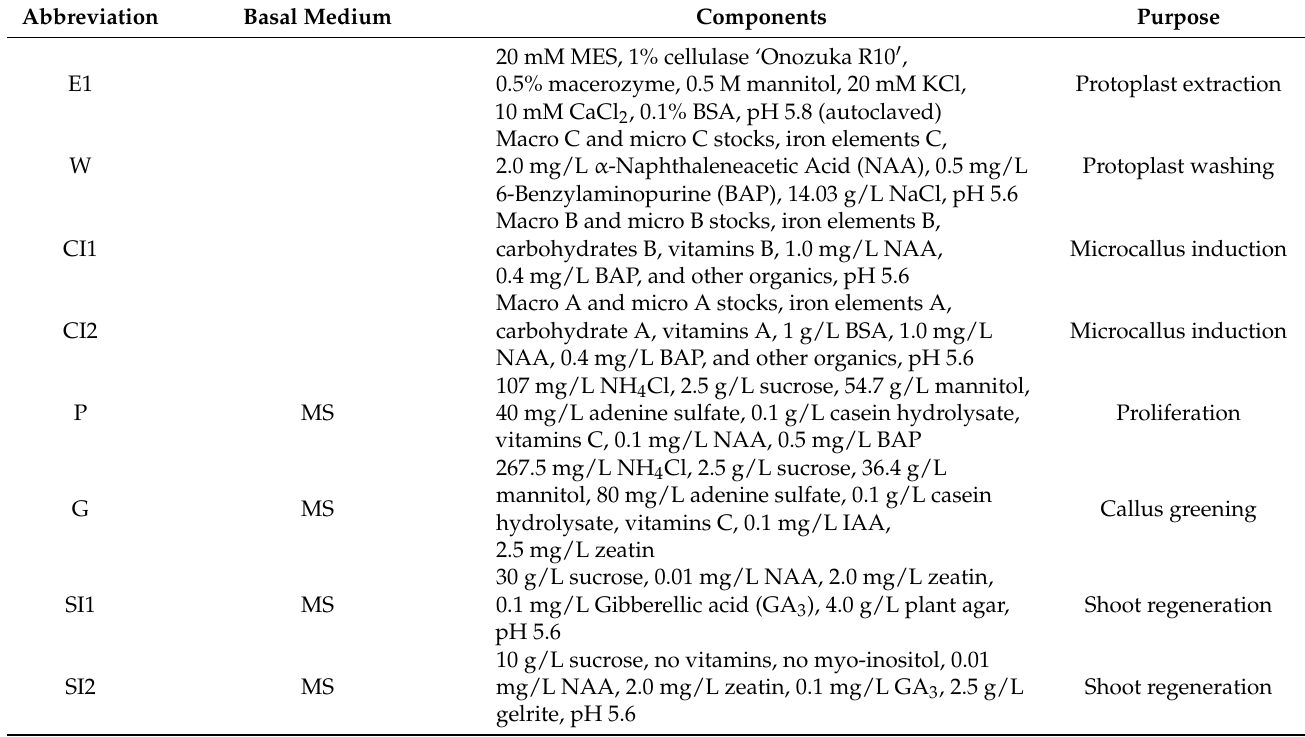
Table 4. Media used for protoplast culture.